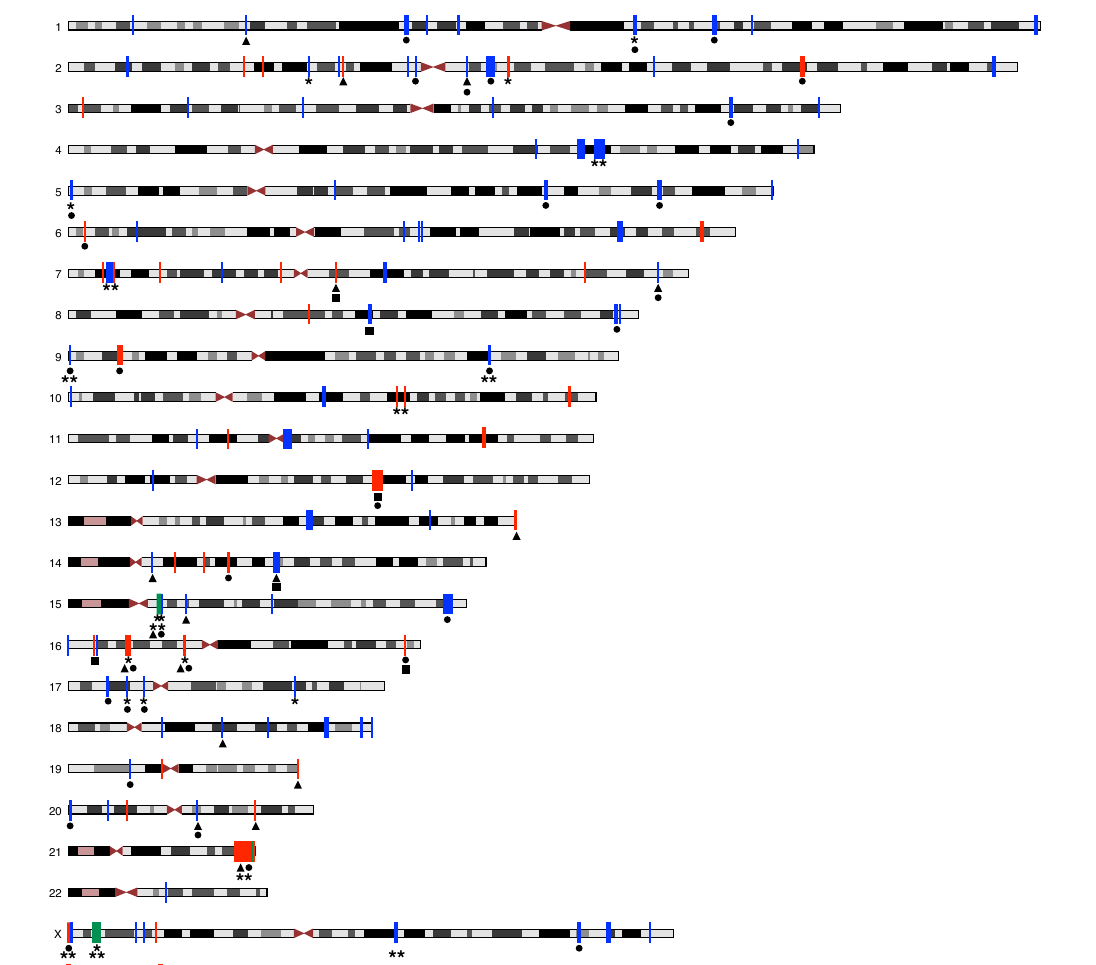
Figure 3. Overview of the copy number variations (CNV) of unknown significance (CNV-US) and the relevant results from our comprehensive re-analysis on a schematic chromosome map. Deletions are red, duplications are blue, regions containing both deletions and duplications are green. Depicted are CNV-US overlapping with a pathogenic region (*), recurrent regions in the study cohort (**), CNV-US containing one or more candidate congenital heart defect (CHD) protein-coding genes ( (cid:78) ), CNV-US containing one or more lncRNA genes expressed in developing human heart ( • ), and CNV-US potentially disrupting topologically associated domain (TAD)-related gene-enhancer interactions potentially relevant for CHD ( (cid:4)